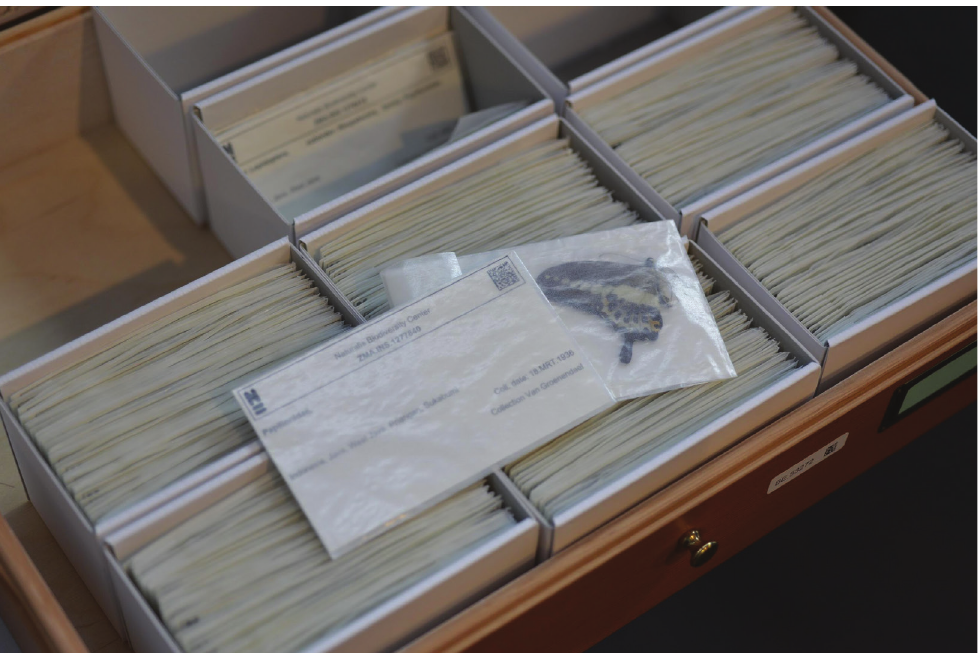
Figure 6. The final storage of the specimens. The specimens are visible through the semi-transparent glassine envelope, and are stored in the cardboard boxes within drawers where they are easily accessible by unique specimen